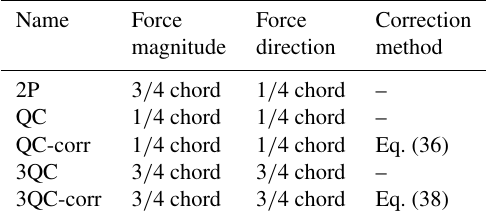
Table 1. Details of different approaches of the generalized lifting- line method that are investigated in the present work. The differ- ences are the chordwise locations where the flow information is used to determine the sectional force magnitude and force